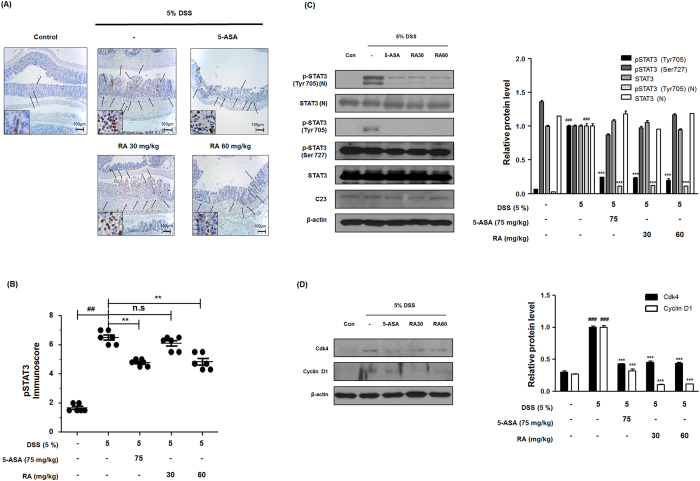
Effect of RA on constitutive activation of STAT3 and its relative gene products in DSS-induced colitis mice.(A) The manifestation and translocation to the nucleus of pSTAT3 (Tyr705) in colon tissues were performed by immunohistochemistry. (B) pSTAT3 (Tyr705) immunoscore in DSS-induced mice was estimated. (C) Nuclear (N) and cytosol (C) extracts were prepared from colon tissues on 7 days of DSS administration and the phosphorylation and nuclear translocation of pSTAT3 were estimated by western blot analysis using specific antibodies. C23 and β-actin were used as internal controls. (D) The expression of STAT3 target protein was determined by western blot analysis using specific antibodies. Relative ratio level was determined by densitometric analysis (Bio-rad Quantity One® Software) normalized to internal controls. Values are the mean ± SD (n = 10); ##P < 0.01, ###P < 0.001 vs control group; ***P < 0.001 vs the DSS-induced group; significances between treated groups were determined using ANOVA and Dunnett’s post hoc test.